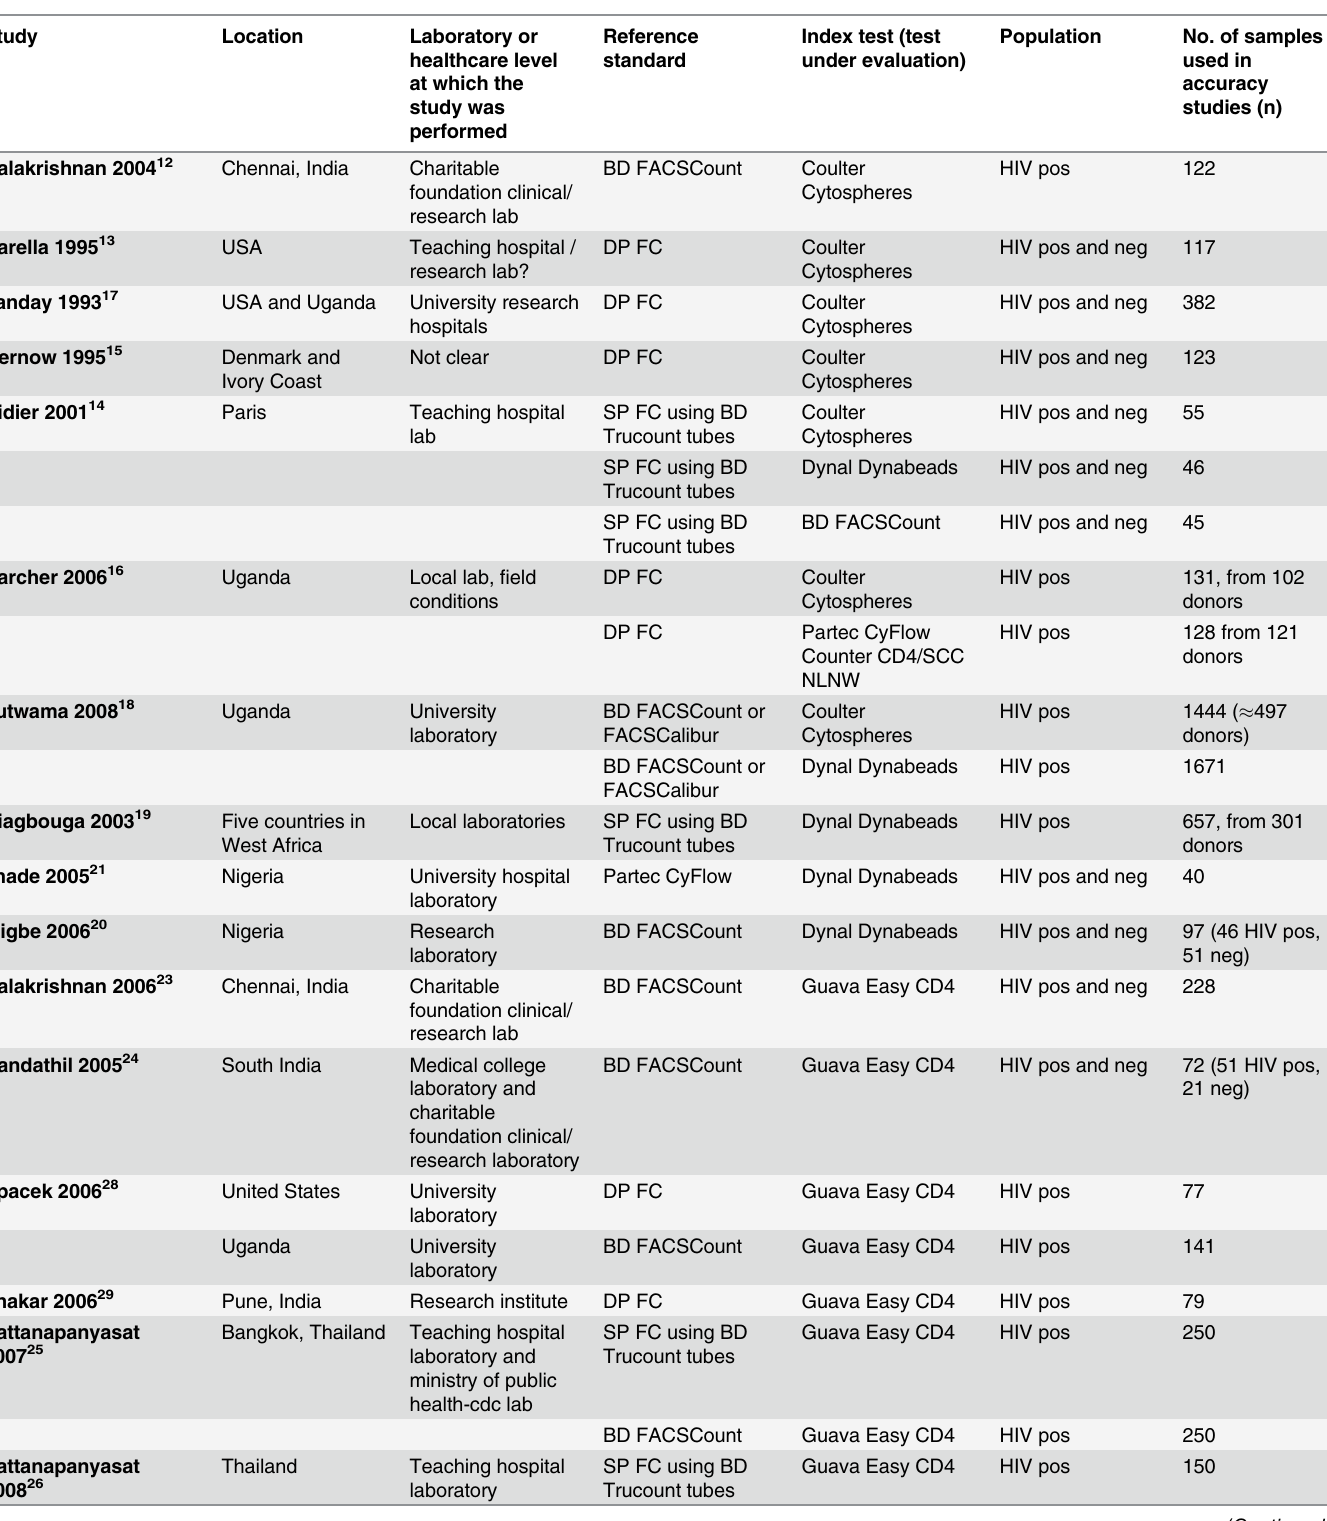
Table 6. Characteristics of included